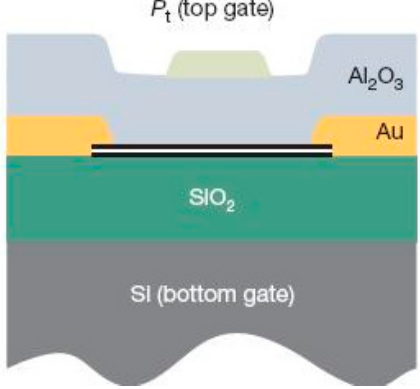
Figure 6. Schematic used in [75] that has been used to show opening of a tuneable bandgap in bilayer graphene. Our bilayer graphene detector design is based on this schematic (reproduced with permission of Nature Publishing Group).